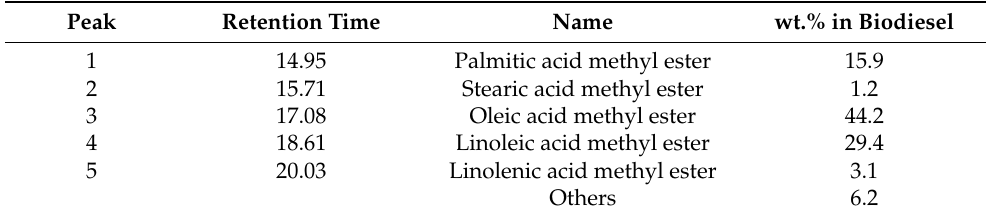
Figure 2. The GC-MS chromatogram of waste cooking oil biodiesel. Table 4. The chemical composition of biodiesel.